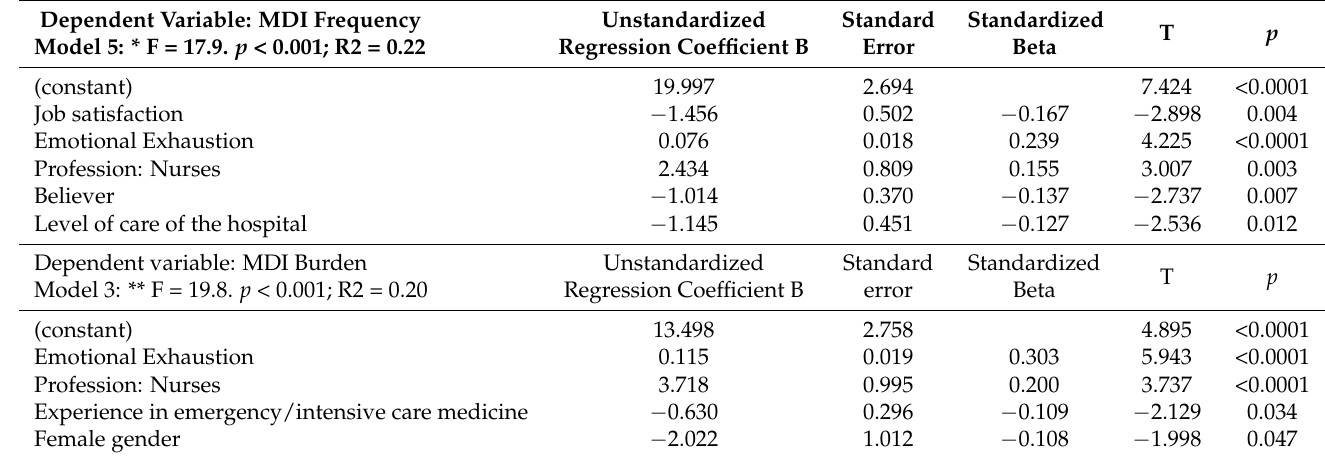
Table 4. Predictors of perceived moral distress (stepwise